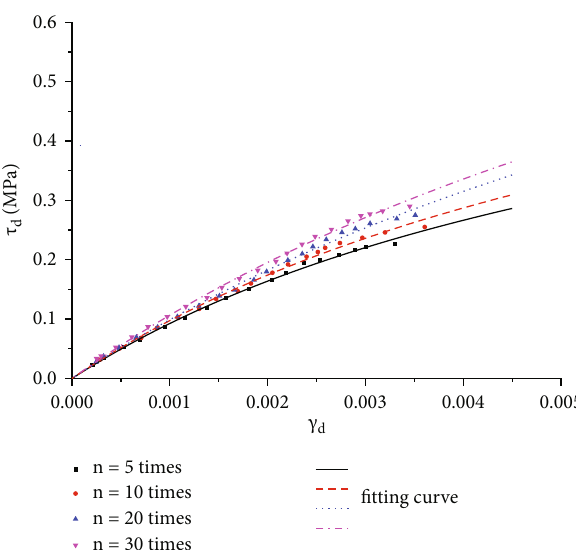
Figure 9: Dynamic stress-strain curves under di ff erent freeze-thaw cycles (-15 ° C).